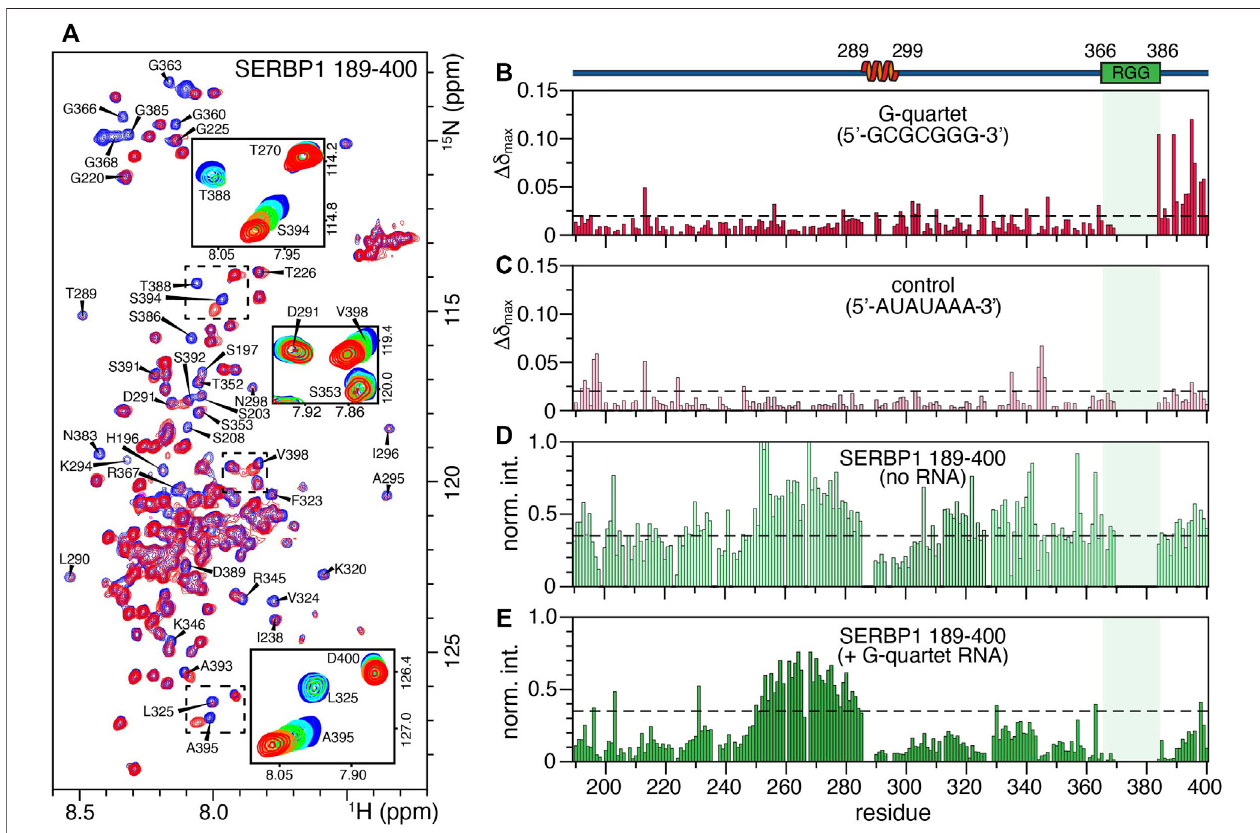
FIGURE 5 | Binding of SERBP1 189 – 400 to a 7-mer RNA oligonucleotide measured by chemical shift perturbations (CSP). (A) Overlay of the 1 H, 15 N-HSQC spectraofSERBP1inabsence(blue) and presence (red) of1:1.6 molar ratioofthe5 ′ -GCGCGGG-3 ′ RNA7-mer. Only thetwotitration points areshown tohighlight the broadening ofglycineresidues observed upon addition ofRNAligand. Theinsetsshow the fulltitration series ofpeaks thatshiftsigni fi cantly.A cartoon representation of the α -helix identi fi ed from chemical shift information and relative position of the RGG boxes (green) is shown above the plots. The shaded box aligns the RGG box over all panels. (B) Maximum CSP ( Δδ max ) induced by the RNA G-quartet ligand binding plotted against SERBP1 189 – 400 sequence. The dashed line represents the mean standard deviation of Δδ max for all peaks, shifts above this threshold are considered signi fi cant. (C) Maximum CSP ( Δδ max ) of a negative control RNA ligand (5 ′ - AUAUAAA-3 ′ ) plottedagainst SERBP1 189 – 400sequence. The dashed linerepresents the meanstandard deviation of Δδ max forall peaks. Normalizedintensitiesofthe 1 H, 15 N-HSQCpeaksofSERBP1189 – 400plottedasafunctionoftheproteinsequence,in (D) theabsenceand (E) presenceof1:1.6molarratioofproteintotheRNA7- mer G-quartet ligand. Dashed lines are the same in both panels and represent the average intensity of SERBP1 peaks in the absence of RNA.